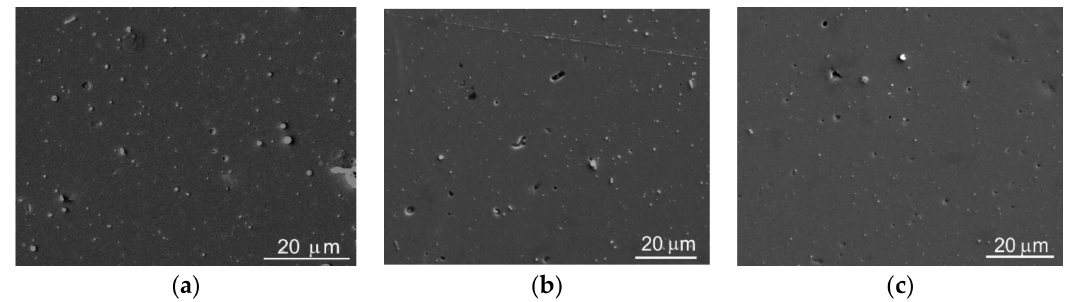
Figure 3. SEM images of the surface of Mo–S–C–H thin-film coatings obtained by reactive pulsed laser deposition (PLD) on steel substrates at the following H 2 S pressures: ( a ) 5.5; ( b ) 9; ( c ) 18